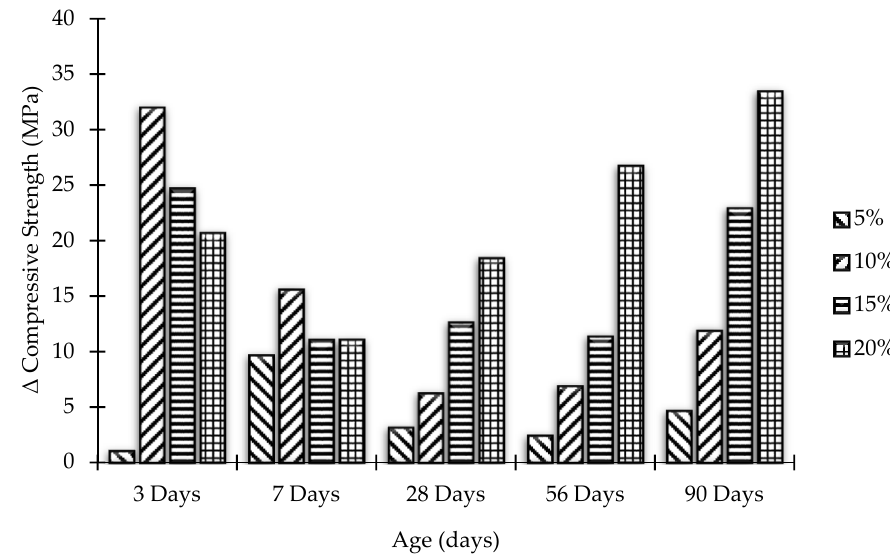
Figure 11. Effect of aging on compressive strength for different replacement levels of MK content.